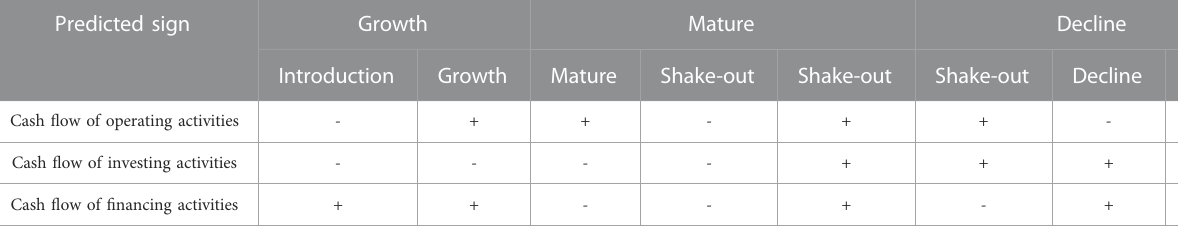
TABLE 2 Cash fl ow patterns of fi rm at different life cycle stages.